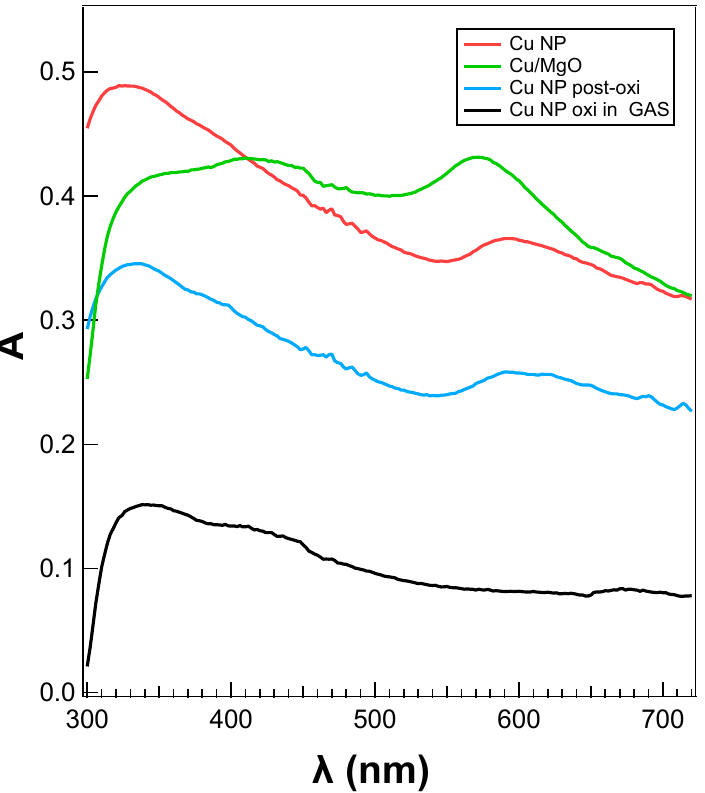
Figure 8. UV–Vis absorbance spectra from Cu/MgO NPs, bare Cu NPs, Cu NPs post-oxidized, and Cu NPs completely oxidized by flowing O 2 in the GAS. The position of the SPR (indicated with red arrows) was blue-shifted for Cu/MgO compared with the bare and post-oxidized Cu.